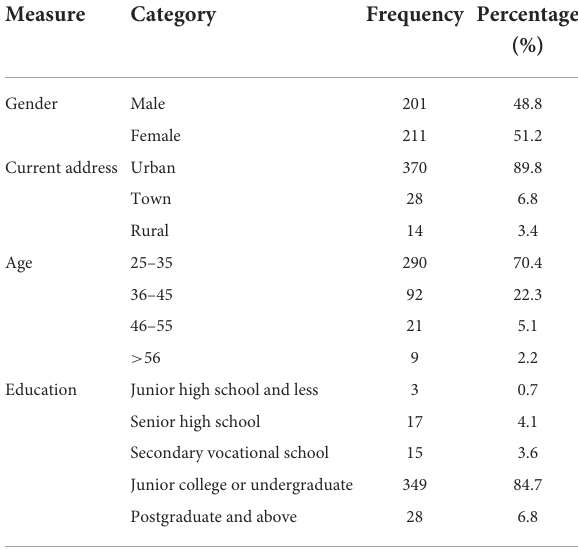
TABLE 1 Descriptive statistics of participants’